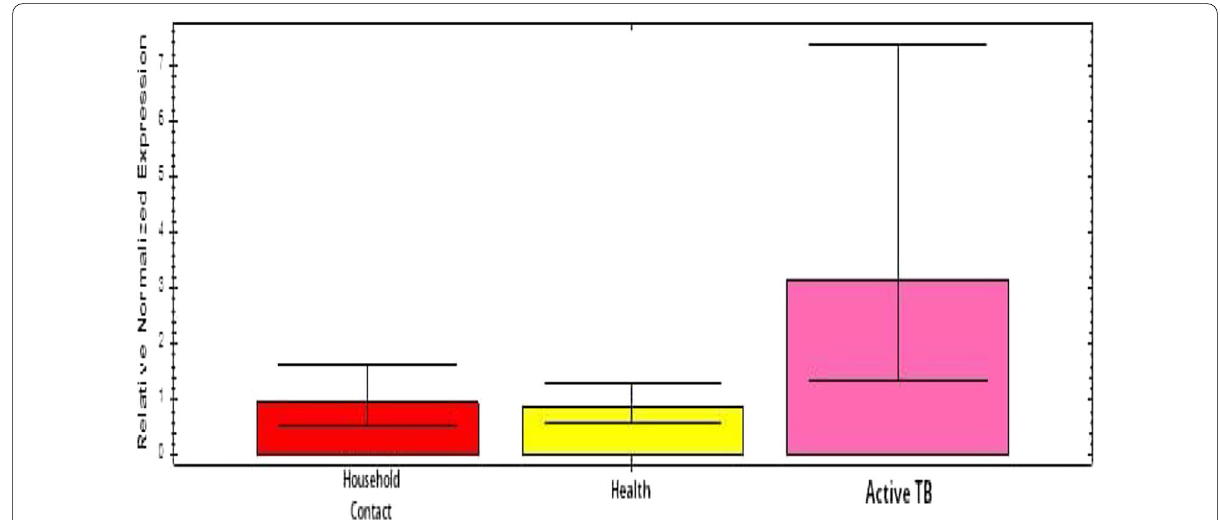
Fig. 2 Bar chart results of gene expression analysis in the active TB group, household contact, and healthy